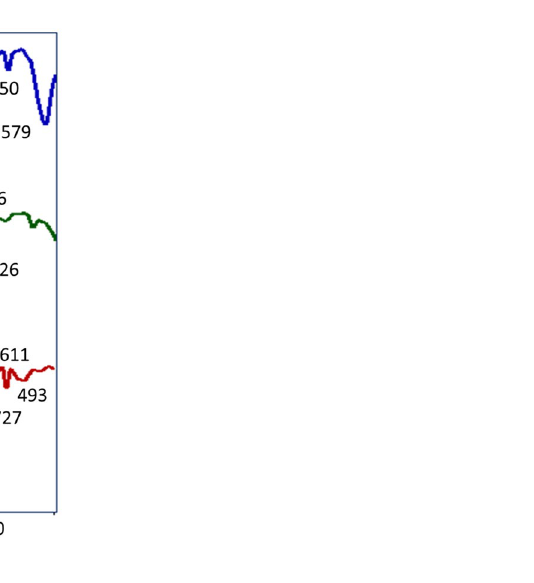
Figure 3. HR-TEM of T-LDH/PbI 2 NC at different magnifications ( A – C ) and EDX of T-LDH/PbI 2 ( D ).